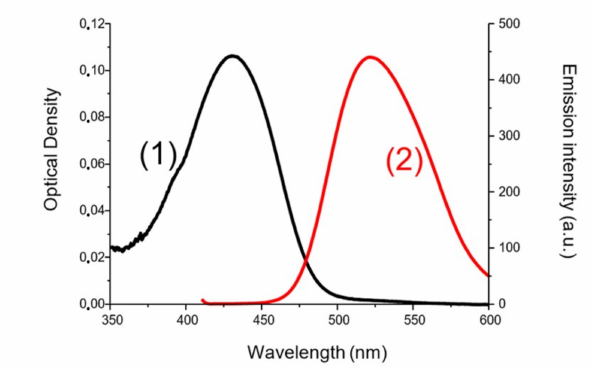
Figure 10. E S1 determination for Napht-B1 (1) absorption spectra and (2) emission spectra in